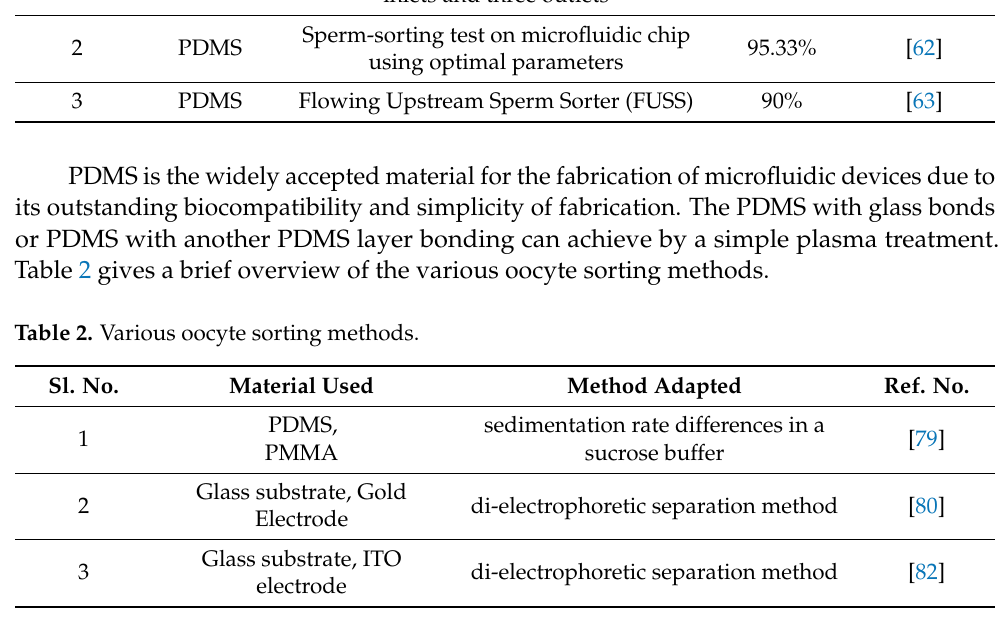
Table 1. Various sperm sorting methods and their sorting efficiency. Material Sl. No. Method Adapted Efficiency Ref. No. Used PDMS microfluidic device with three PDMS PDMS